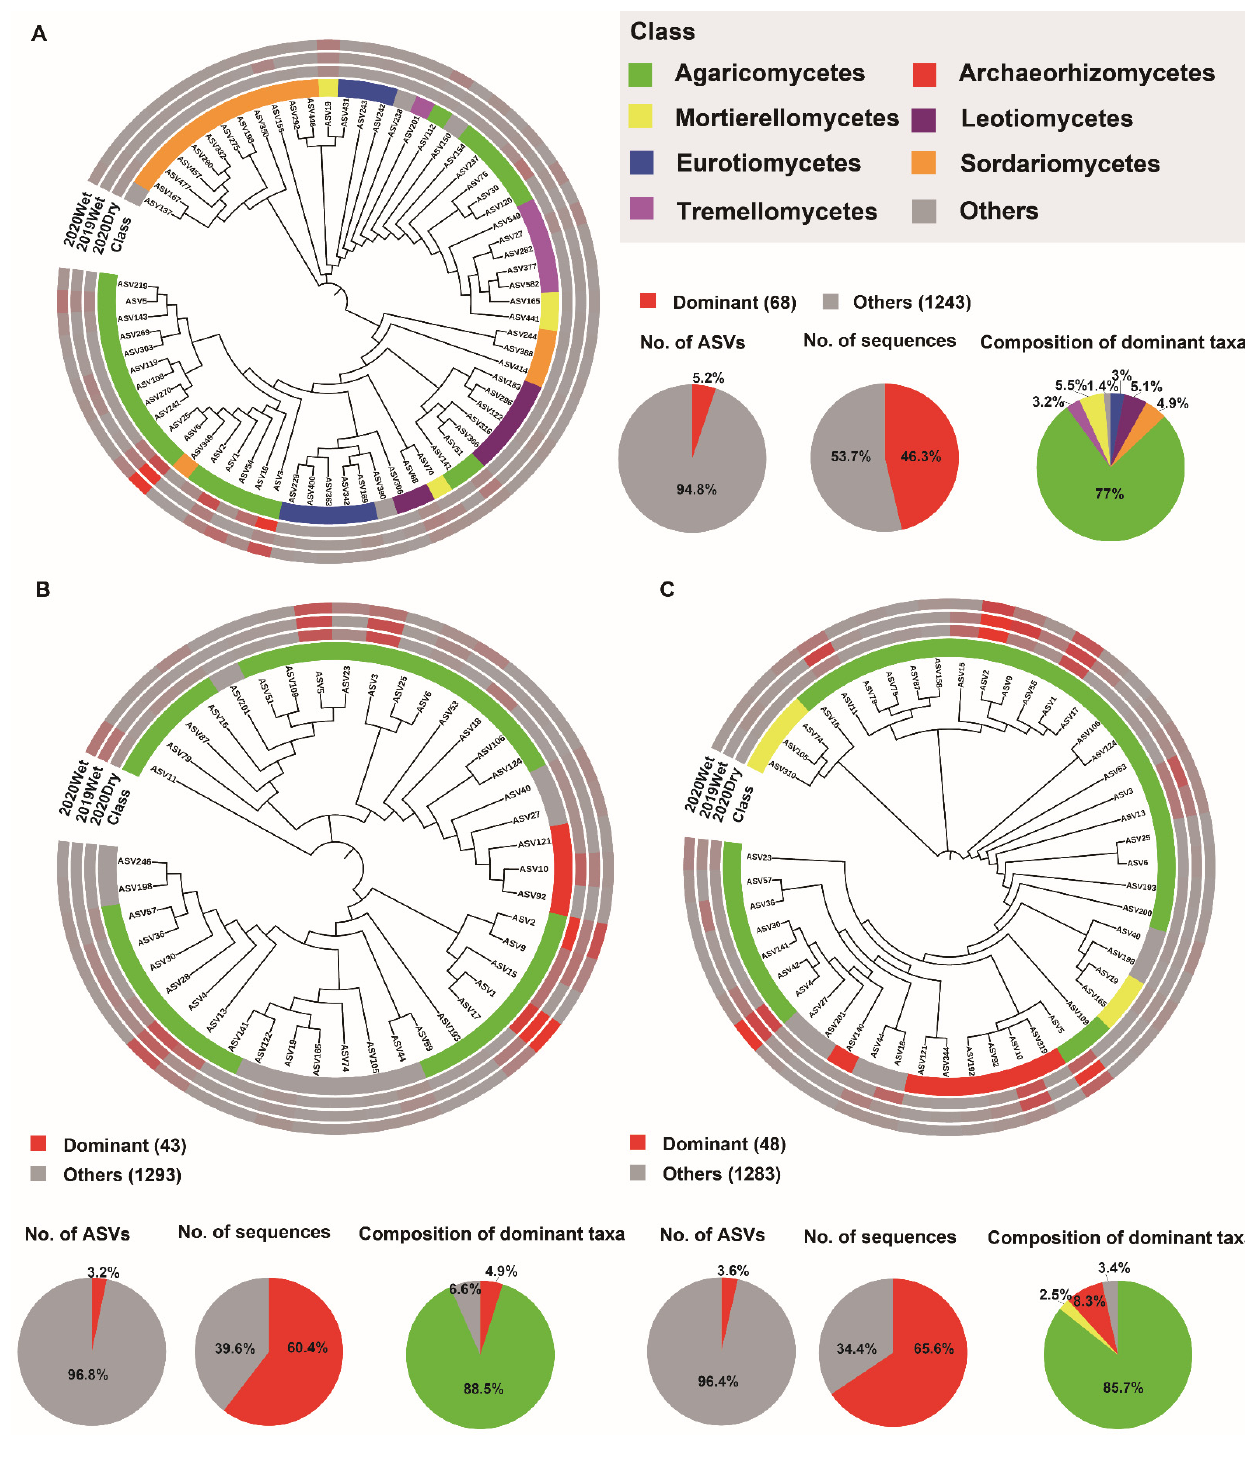
Figure 5. Phylogenetic tree, taxonomic composition, and distribution patterns of soil layer fungal microbiome dominant taxa. ( A ) Identification of dominant taxa in HF (n = 72). ( B ) Identification of dominant taxa in OS (n = 72). ( C ) Identification of dominant taxa in OM (n = 72). The dominant taxa were defined as ASVs present in more than 50% of all samples and with an average relative abundance ≥ 0.2%. Low abundance classes with <2% of the total sequences of dominant taxa across soil layer are grouped into ‘Others’. HF: humic fragmented litter, OS: organic soil, OM: organic mineral soil. ASVs: amplicon sequence variants. 2019Wet: samples collected from wet season in